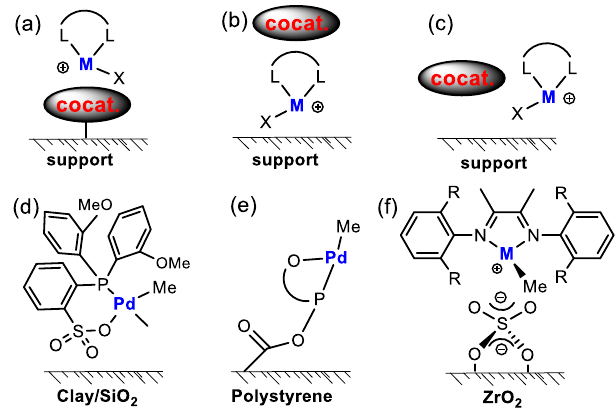
Fig. 1 Commonly used heterogenization strategies and examples of known heterogeneous late-transition metal catalysts. a – c Commonly used heterogenization strategies. d – f Examples of known heterogeneous late-transition metal catalysts for the copolymerization of ethylene with polar